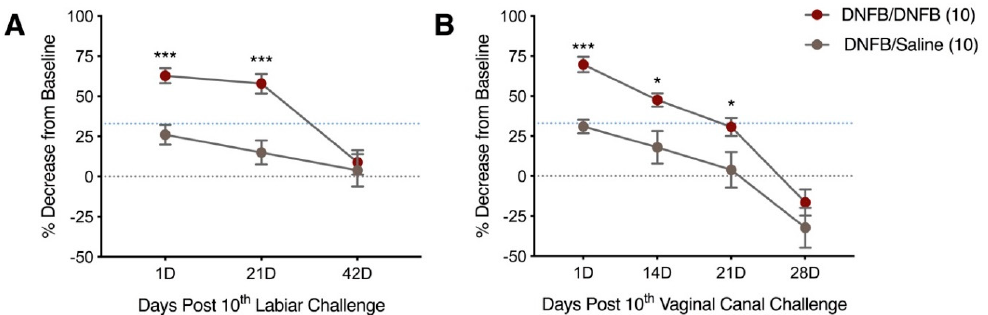
Figure 2. Ten daily DNFB challenges on the labiar skin and in the vaginal canal results in increased sensitivity that persists 21 days post tenth challenge. ( A ) Percent decrease from baseline measurements 1, 21, and 42 days after 10 labiar challenges, n = 18–27 and ( B ) 1, 14, 21, and 28 days post vaginal canal challenge. Only post-treatment withdrawal responses that show a 33%, represented by blue dotted line, or greater decrease from baseline withdrawal thresholds are considered hyperalgesic. *** and * represent a p -value of p < 0.001 and p < 0.05 respectively n = 9–18.